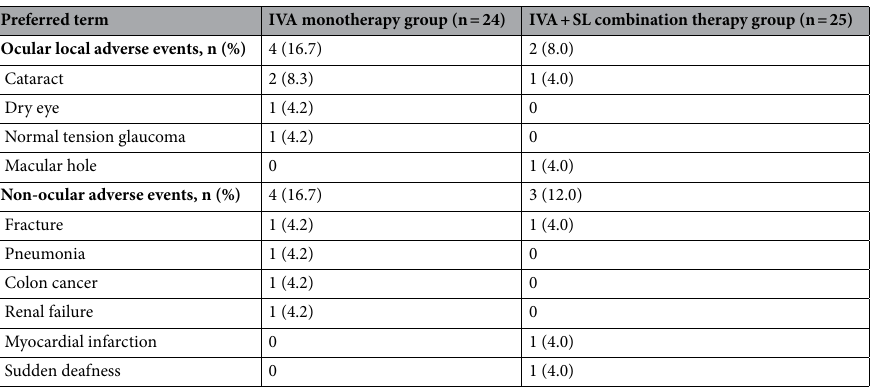
Table 1. Adverse events (FAS). FAS full analysis set; IVA intravitreal injection of aflibercept; SL subthreshold